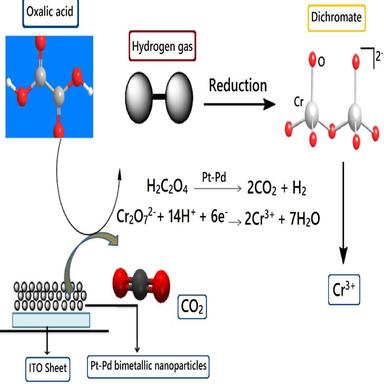
The possible mechanism of bimetallic PtePd/ITO promoted Cr(VI) reduction with OA).